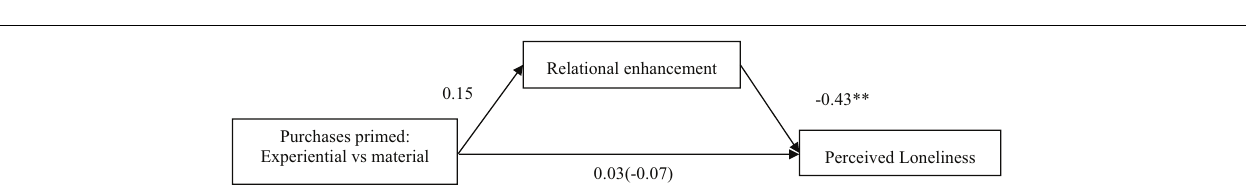
FIGURE 3 | Mediation analysis (in high loneliness primed condition): relational enhancement as a mediator (Experiment 2). Note * p -values < 0.05; ** p -values < 0.01; *** p -values < 0.001; NS, non-significant.